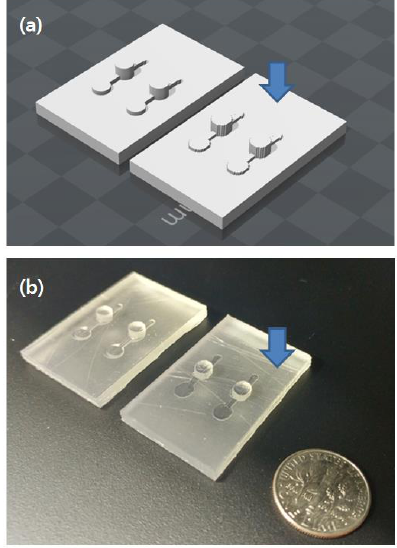
Figure 3. Comparison between MineLoC and conventional design tool (SolidWorks). Master templates generated using MineLoC method is marked with an arrow. ( a ) 3D printer-readable file converted models generated by the proposed method and the conventional method; and ( b ) SLA 3D printed master templates.